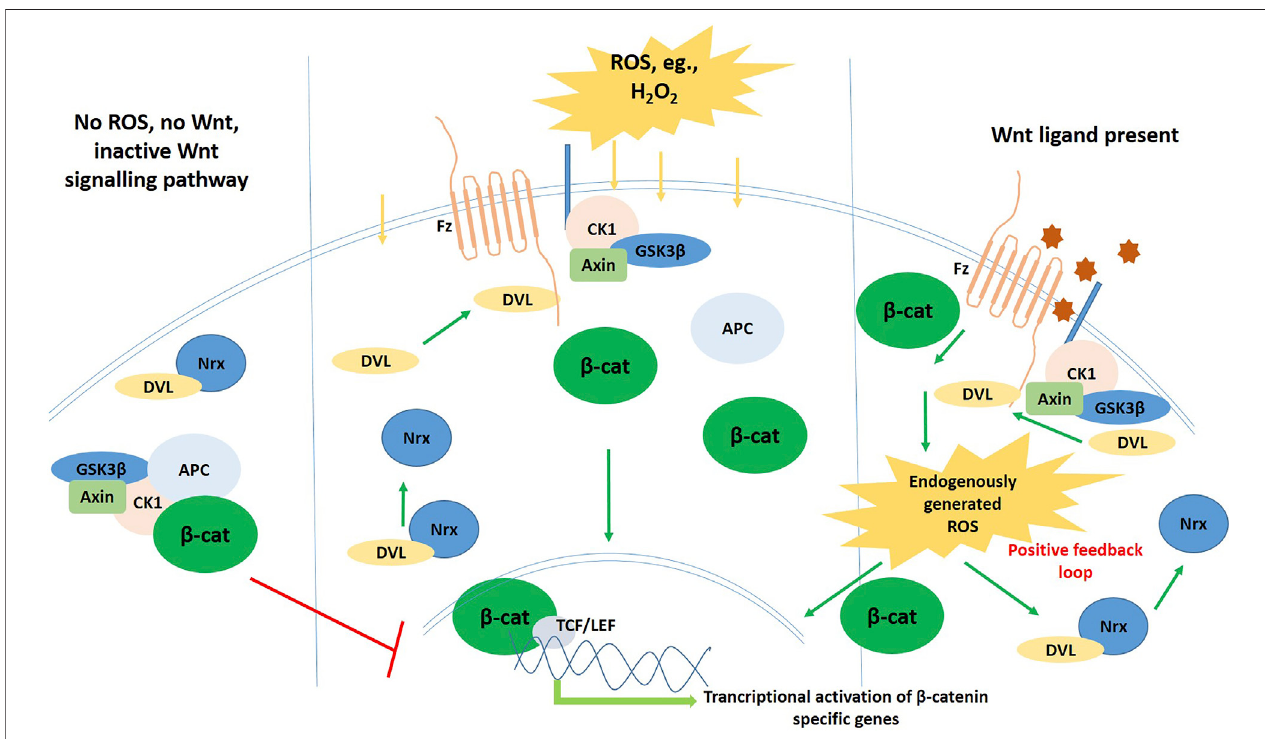
FIGURE 4 | Schematic diagram showing the crosstalk and interplay of ROS with